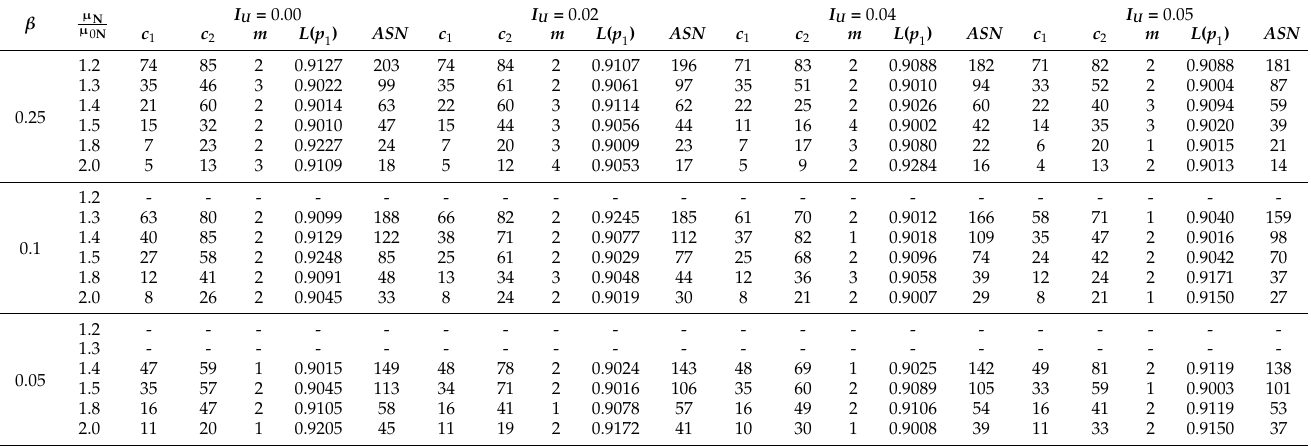
Table 7. The MDS design values for α = 0.10, ν = 1, and a = 0.50.